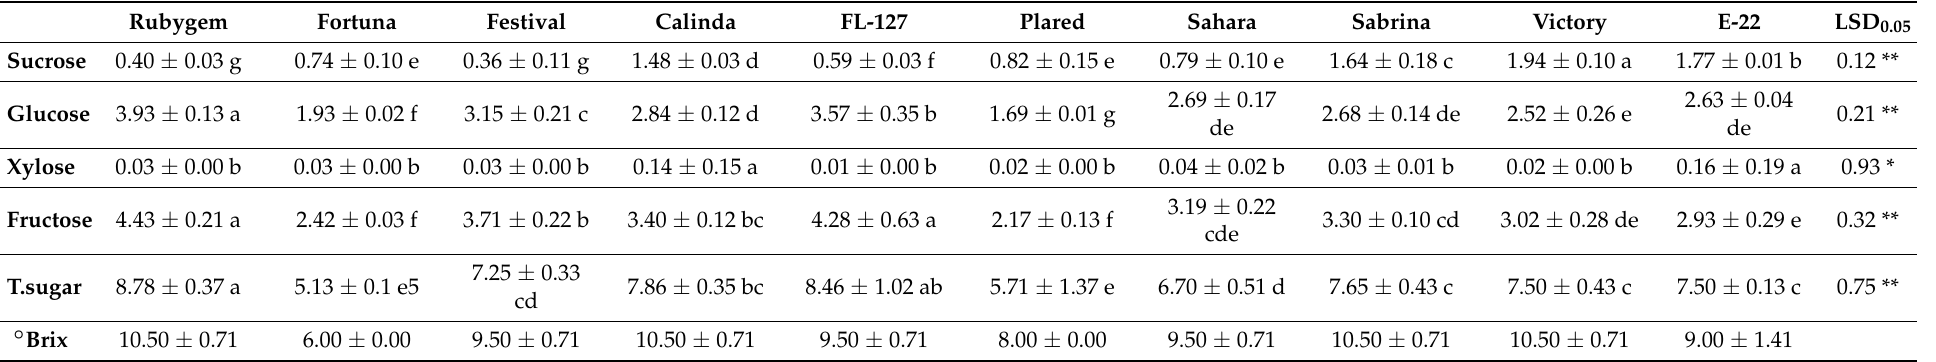
Table 2. The sugars (%), total sugar (%) and ◦ Brix in fruits of ten strawberry